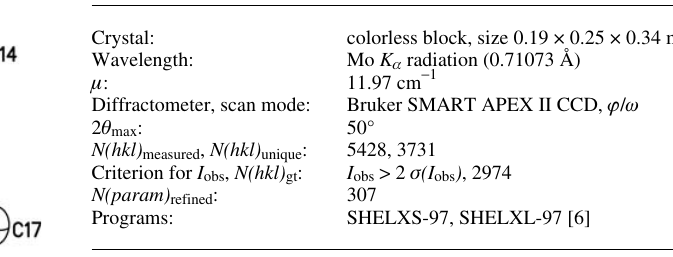
Table 1. Data collection and handling.